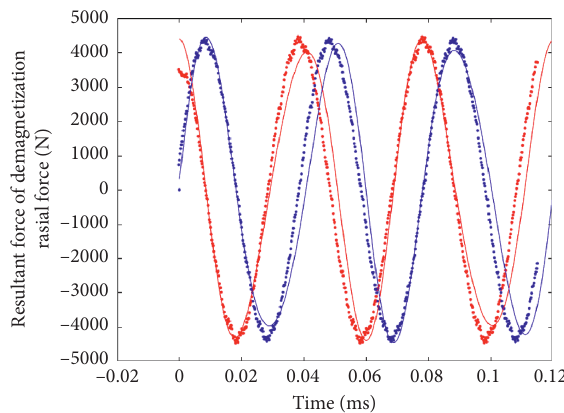
Figure 6: The diagram of curve of UMP in directions x, y .